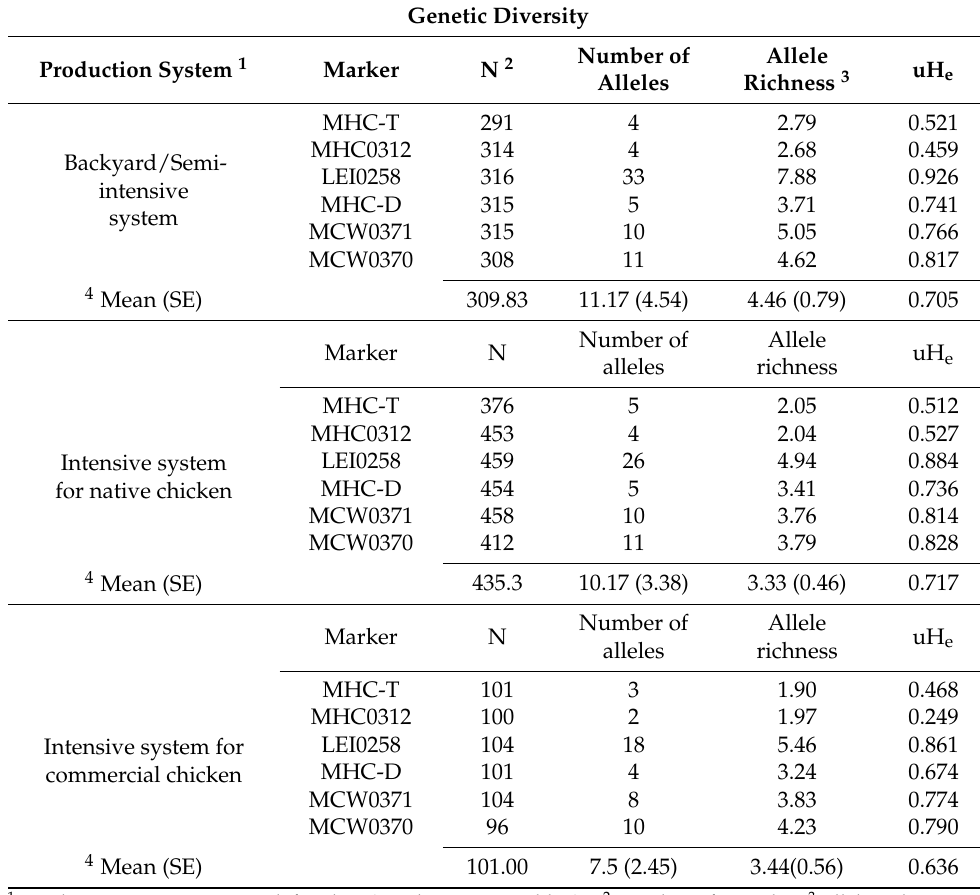
Table 5. Allele number and allele richness and unbiased expected heterozygosity difference for Set 2 MS markers in chicken populations grouped by their production